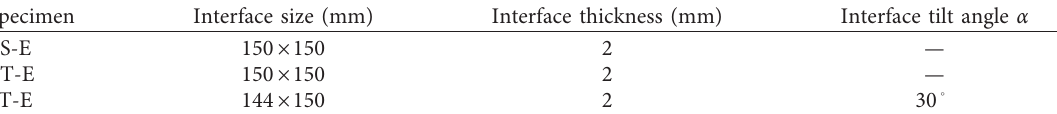
Table 1: Detailed information of the specimen.